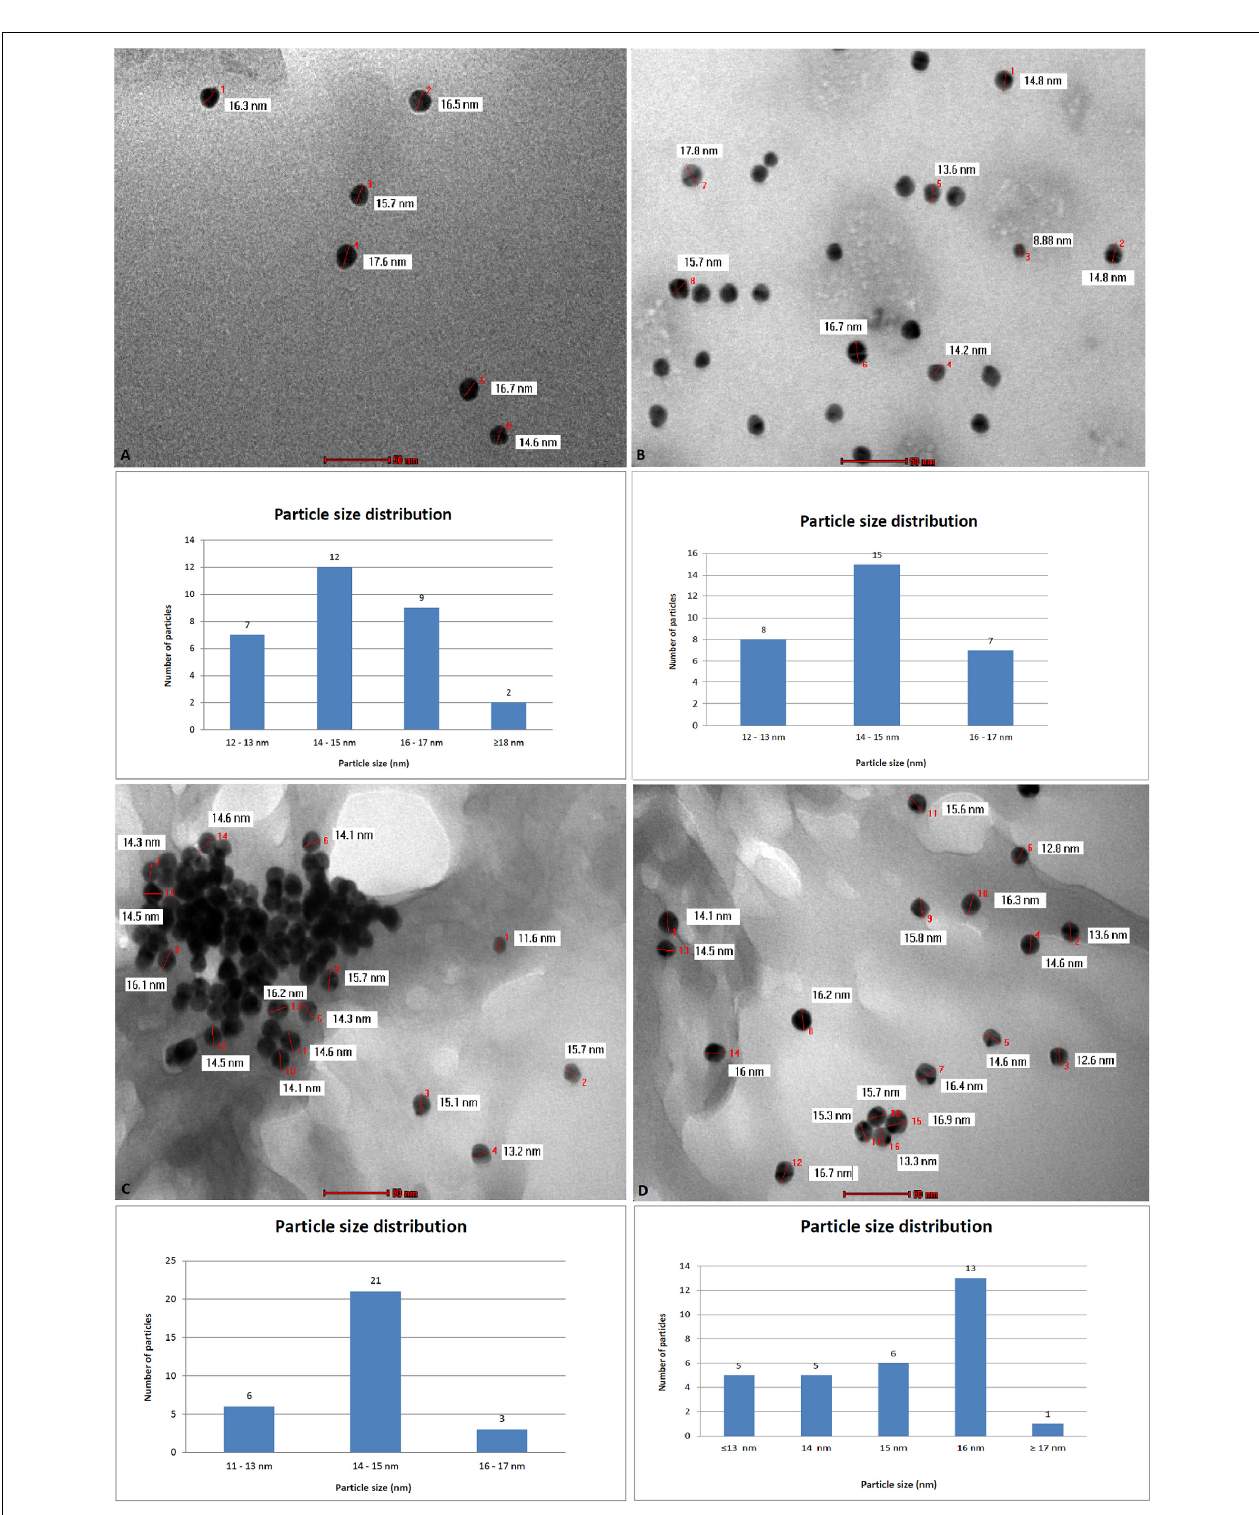
FIGURE 2 | Transmission electron microscopy (TEM) analysis and particle size distribution for nanogold samples: AuNP (A) , AuNP Peg (B) , AuNP + Bet (C) , AuNP Peg + Bet (D).